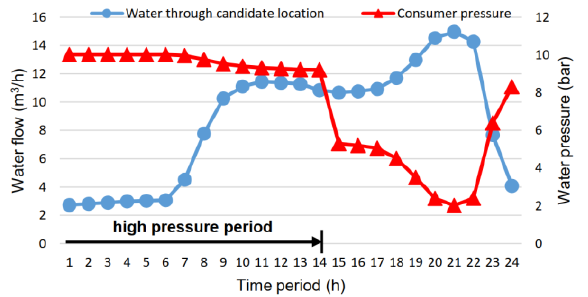
Figure 12. Water flow through candidate location and downstream consumer pressure.